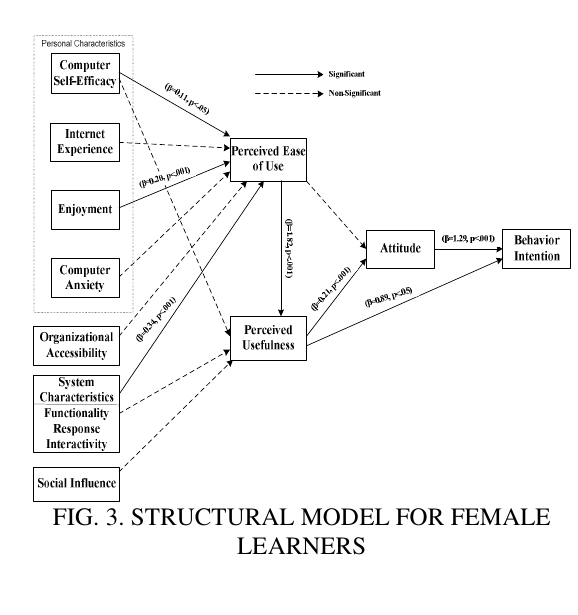
FIG. 2. STRUCTURAL MODEL FOR MALE